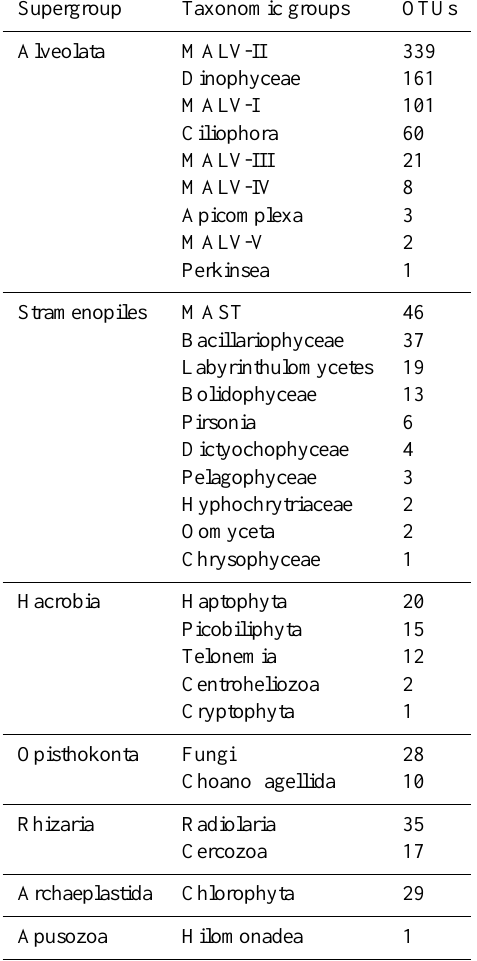
Table 3. Higher-level taxonomic distribution of protistan OTUs de- fined at 97% sequence similarity.